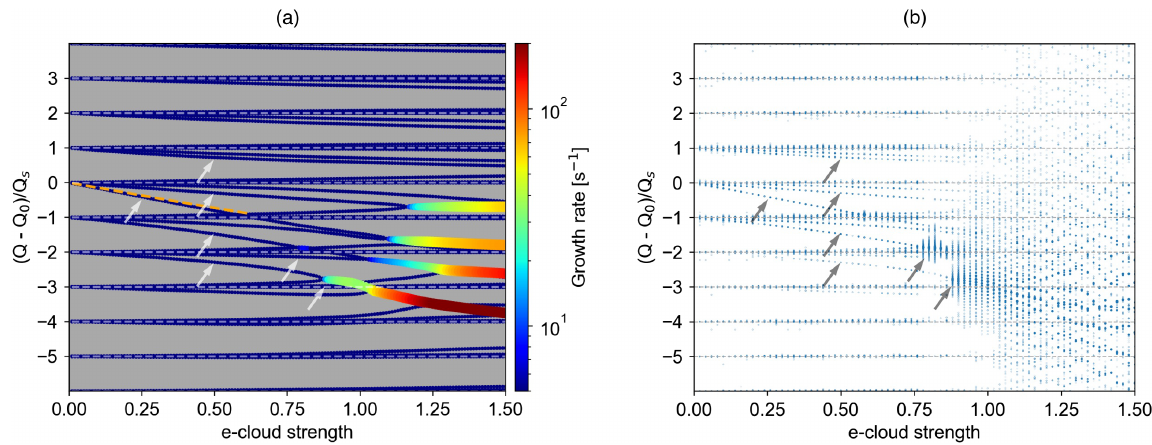
¼ 0 , Δ Q ≠ 0 . (a) Eigenvalues from linearized Vlasov equation, (b) P y HEADTAIL simulations Φ R